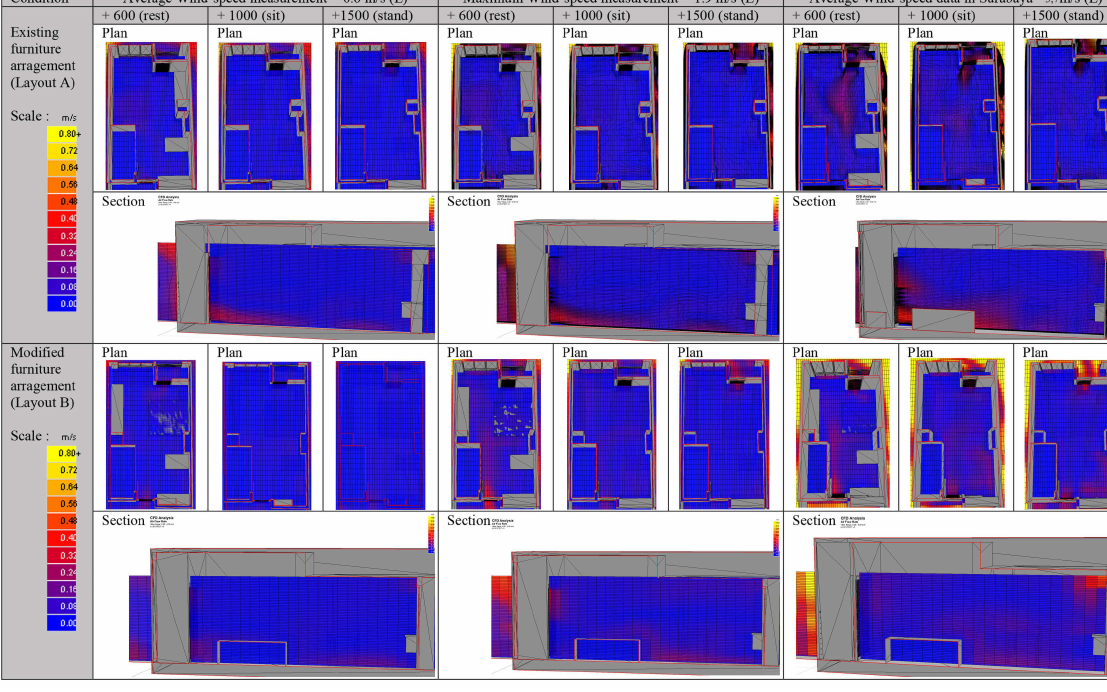
Fig. 5. Condition 3a and b: Change Back The Pivot Window To Fixed